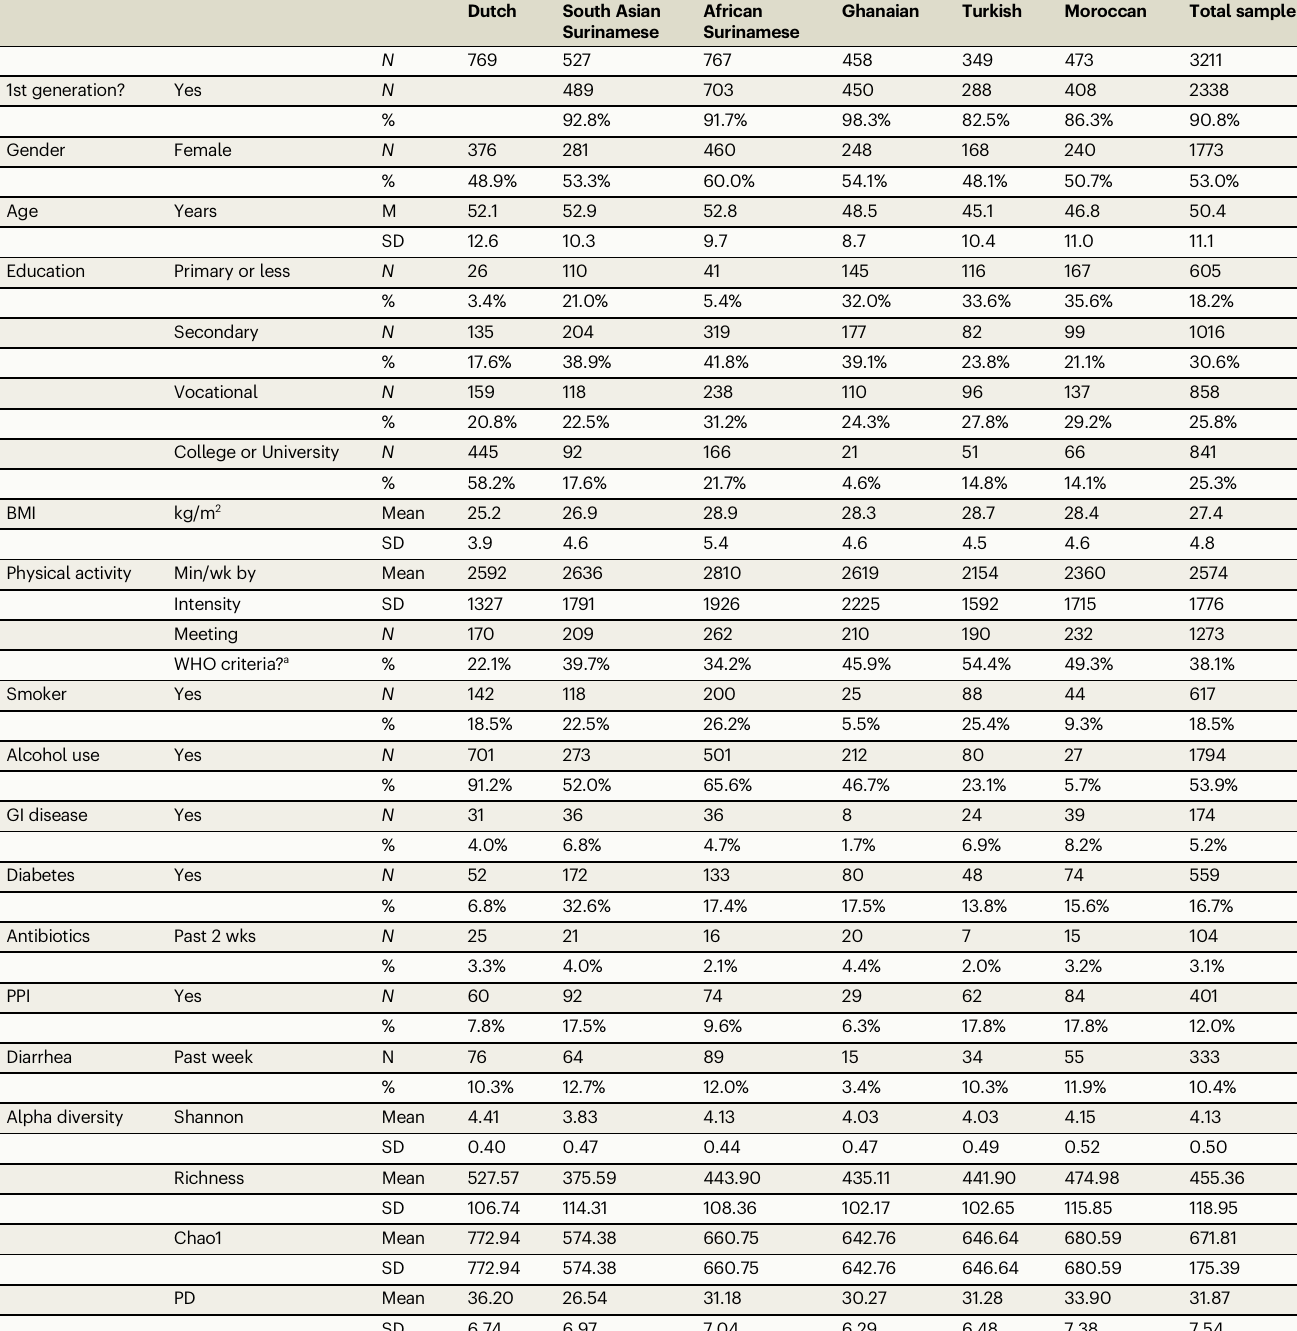
Table 1 | Summary data of the study sample